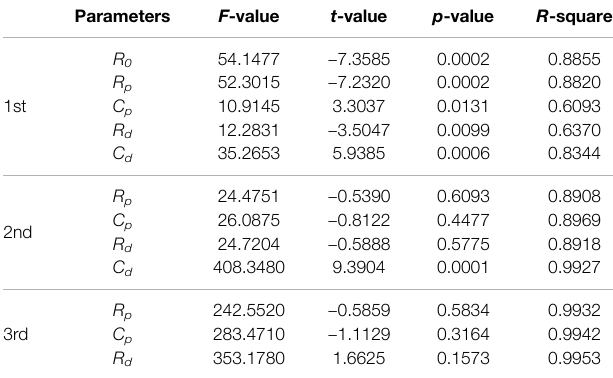
TABLE 2 | Indexes of MSR for Cell